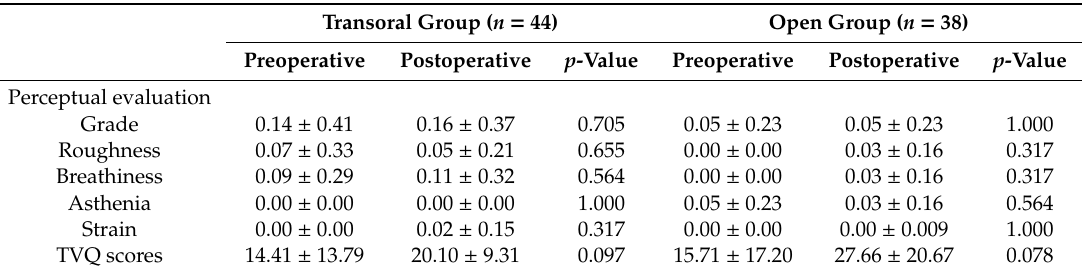
Table 2. Subjective voice outcomes after use of the transoral endoscopic thyroidectomy vestibular approach (TOETVA) or open